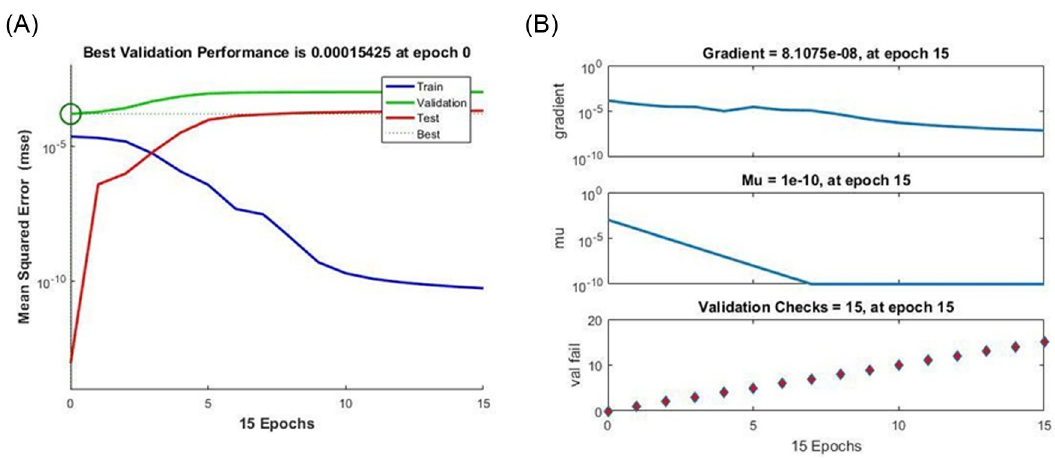
Fig 6. A-B Performance data obtained (ANN) over entire training data and gradient loss for diosgenin.